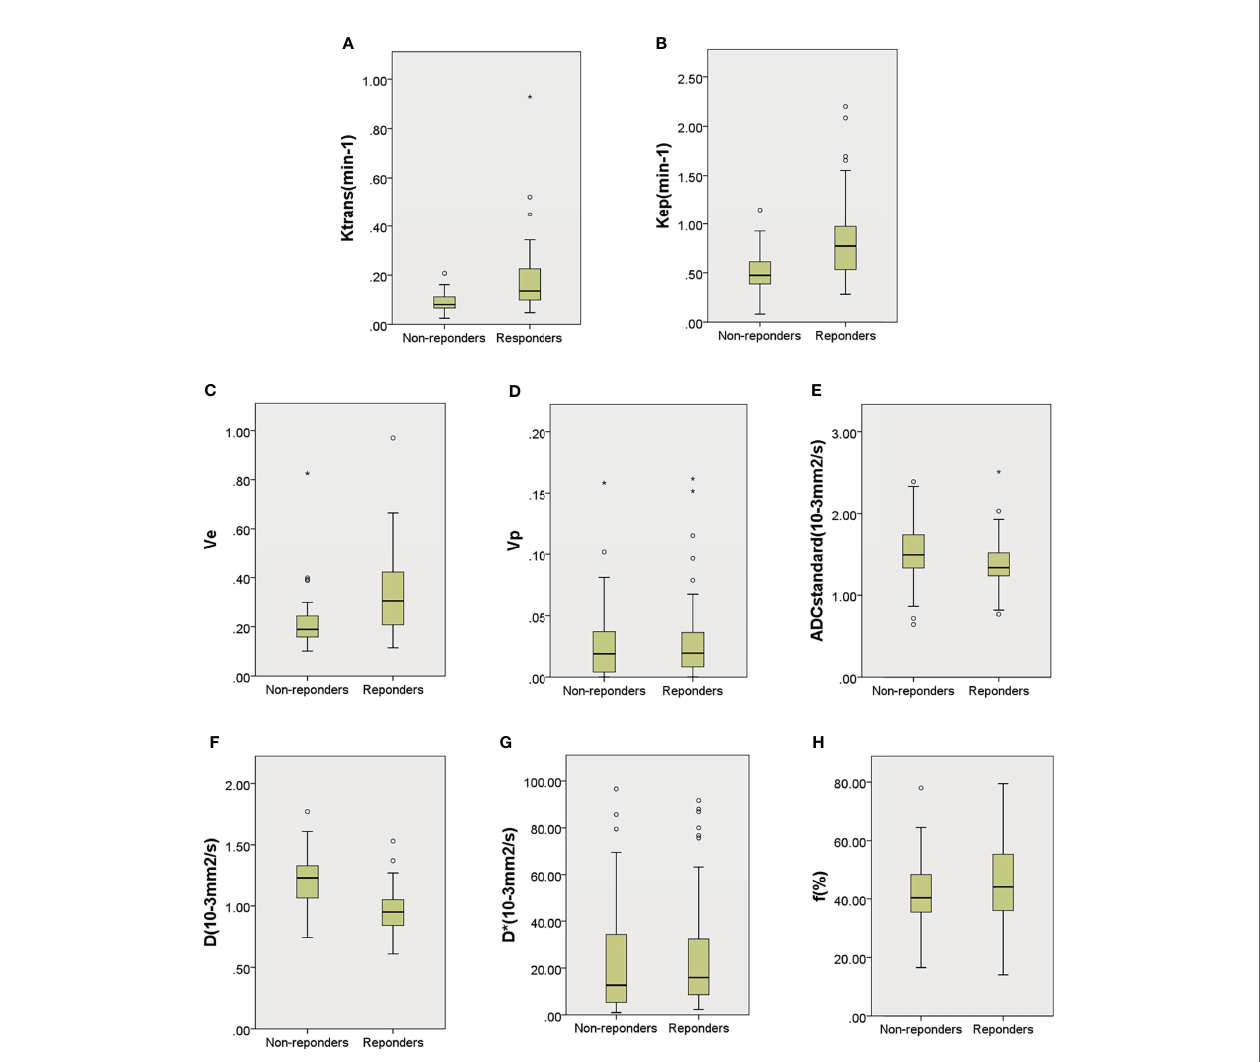
FIGURE 4 | Boxplots for K trans (A) , k ep (B) , v e (C) , v p (D) , ADC standard (E) , D (F) , D* (G) , and f (H) of locally advanced gastric cancer in the pathological responder and non-responder groups. The top and bottom of the boxes are the 25th and 75th percentiles, respectively. The mid lines and bars indicate the medians and the 5th – 95th percentiles, respectively. Circles indicate outliers, stars represent extreme